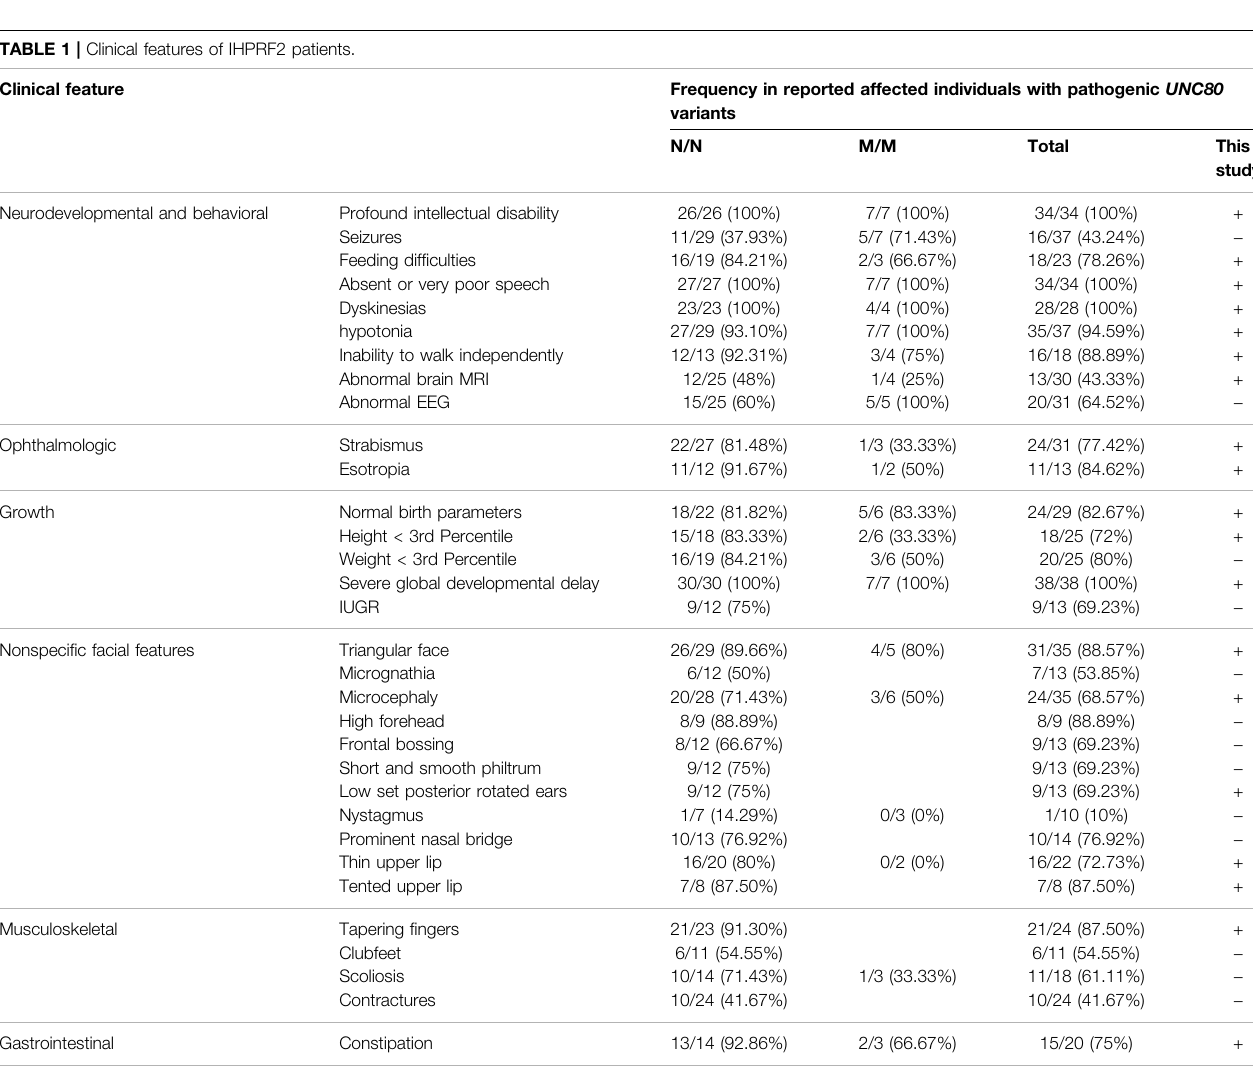
TABLE 1 | Clinical features of IHPRF2